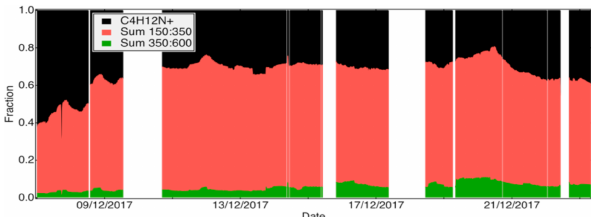
Figure 4. Contribution of the reagent ion, sum of ions from 150 to 350Th and sum of ions from 350 to 600Th to total ion count throughout the campaign for the amine CI-APi-TOF. Only a neg- ligible fraction of the signal was found below 150Th (excluding C 4 H 12 N +